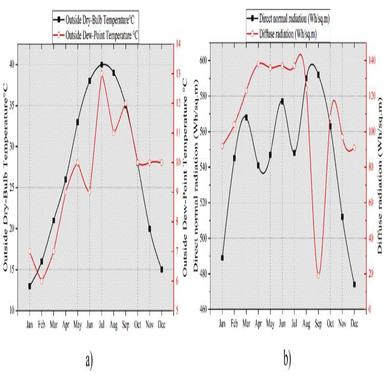
Ahvaz weather conditions; a) temperature and b) radiation.